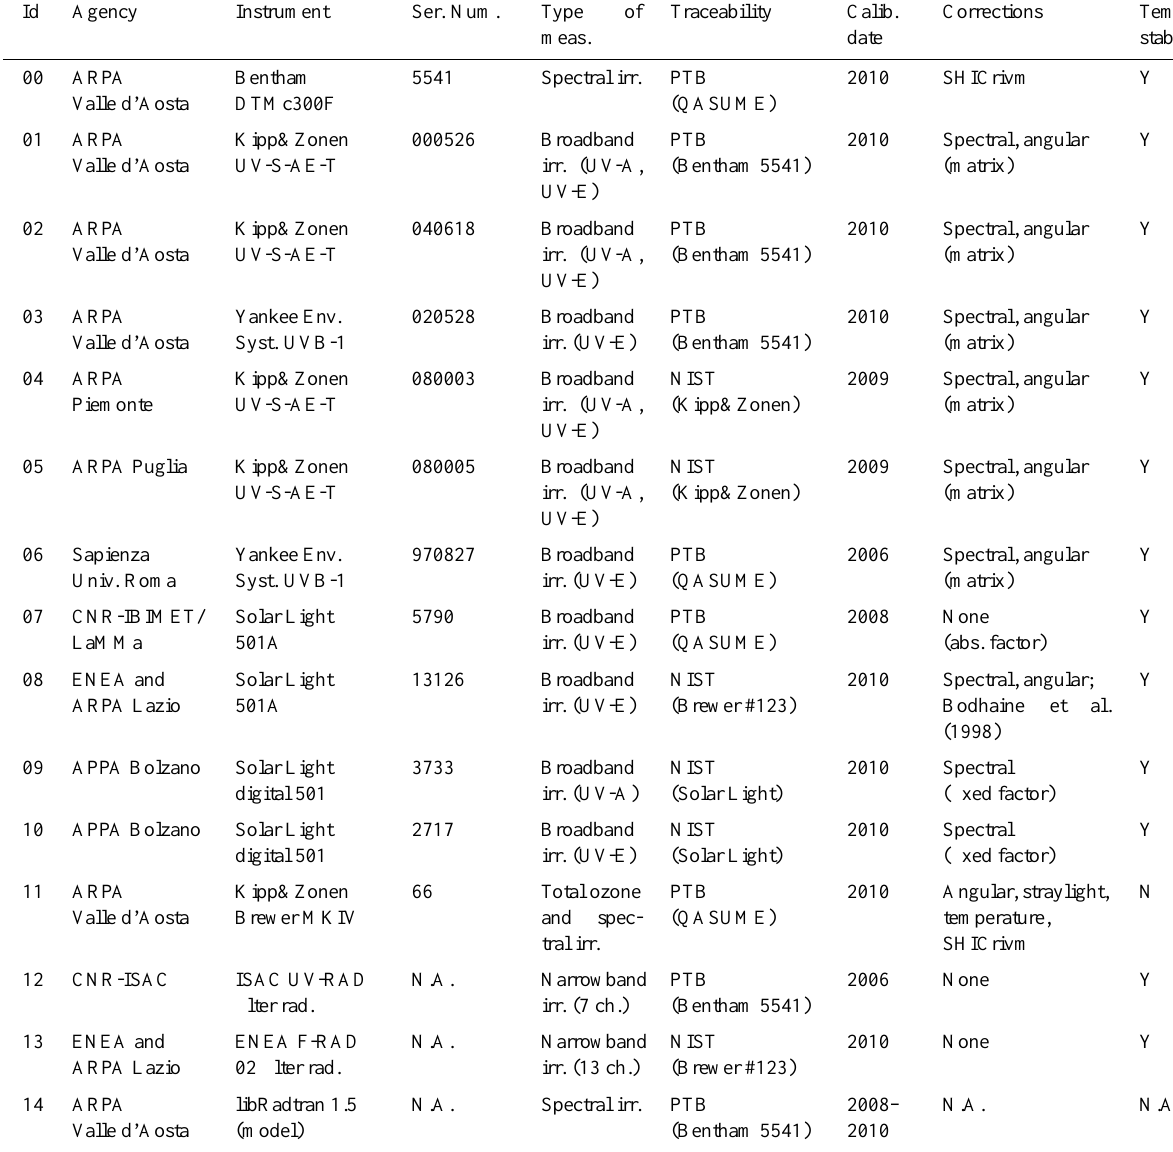
Table 2. Instruments and agencies participating to the comparison campaign. The institute to which the measurements are traceable is stated (in parentheses, the name of the reference instrument or facility through which the traceability is reached). The traceability was specified for the model, too, since some parameters were fixed with reference to Bentham